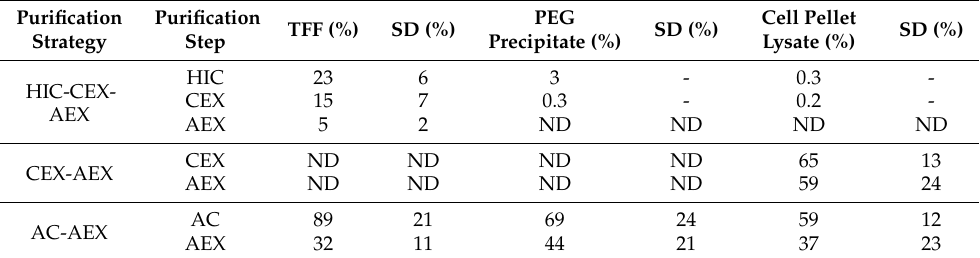
Table 1. Remaining percentage of the original vg amount of rAAVs after the distinct process